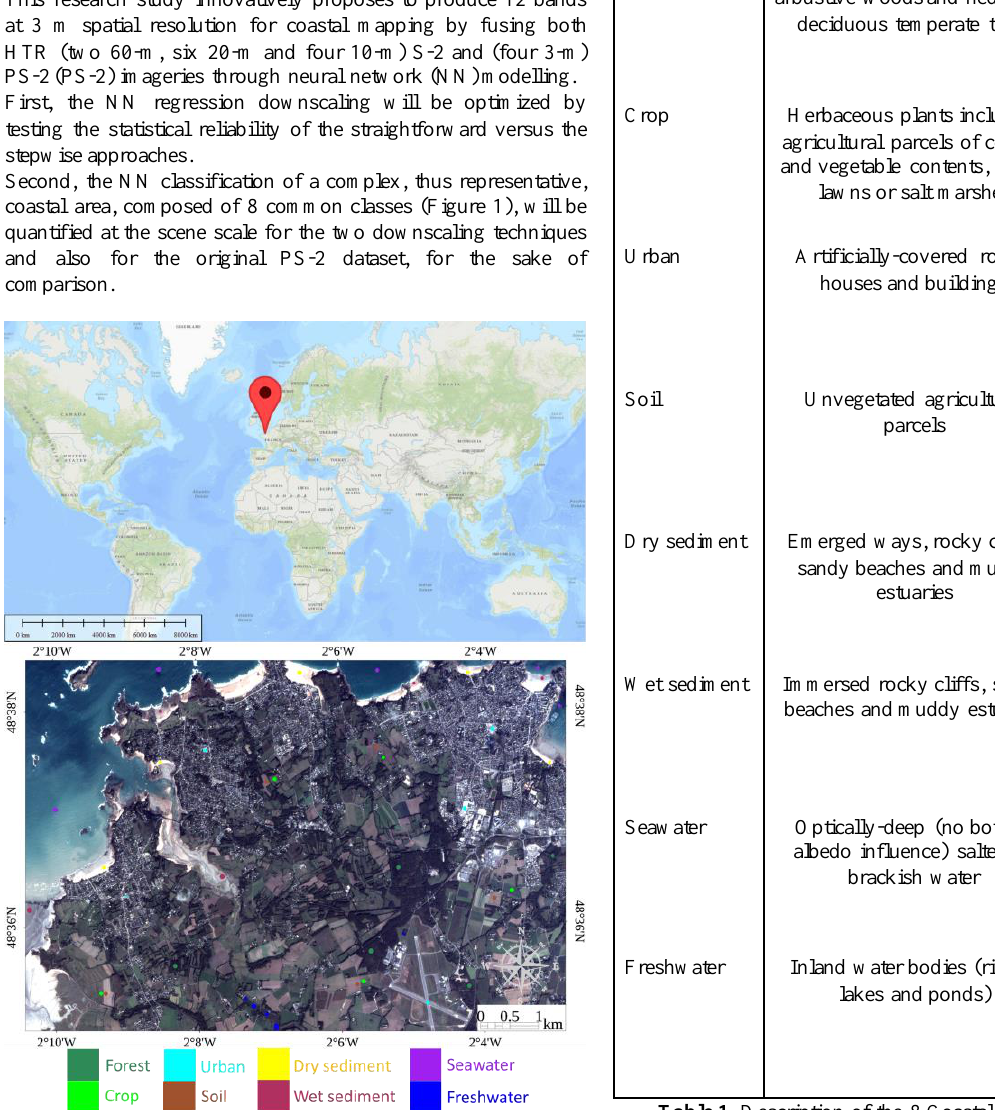
Table 1 . Description of the 8 Coastal Use / Coastal Cover